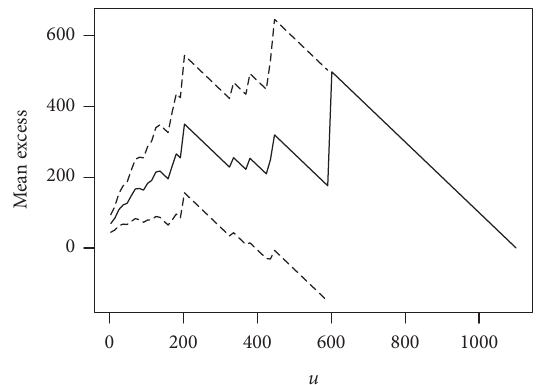
Figure 3: Mean excess plot of